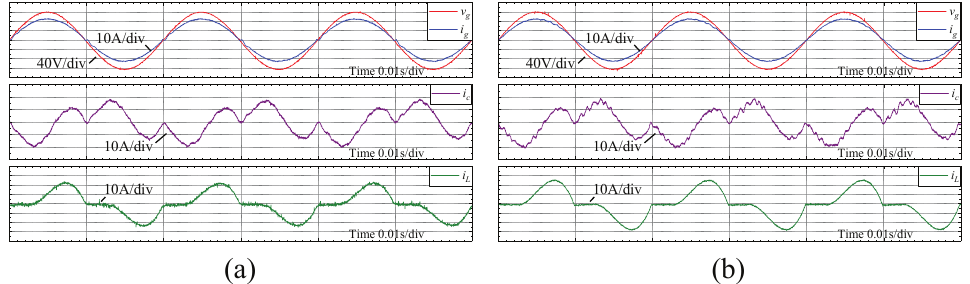
Figure 14. The current waveform at 50Hz when different controllers are used. ( a ) the proposed RC. ( b )